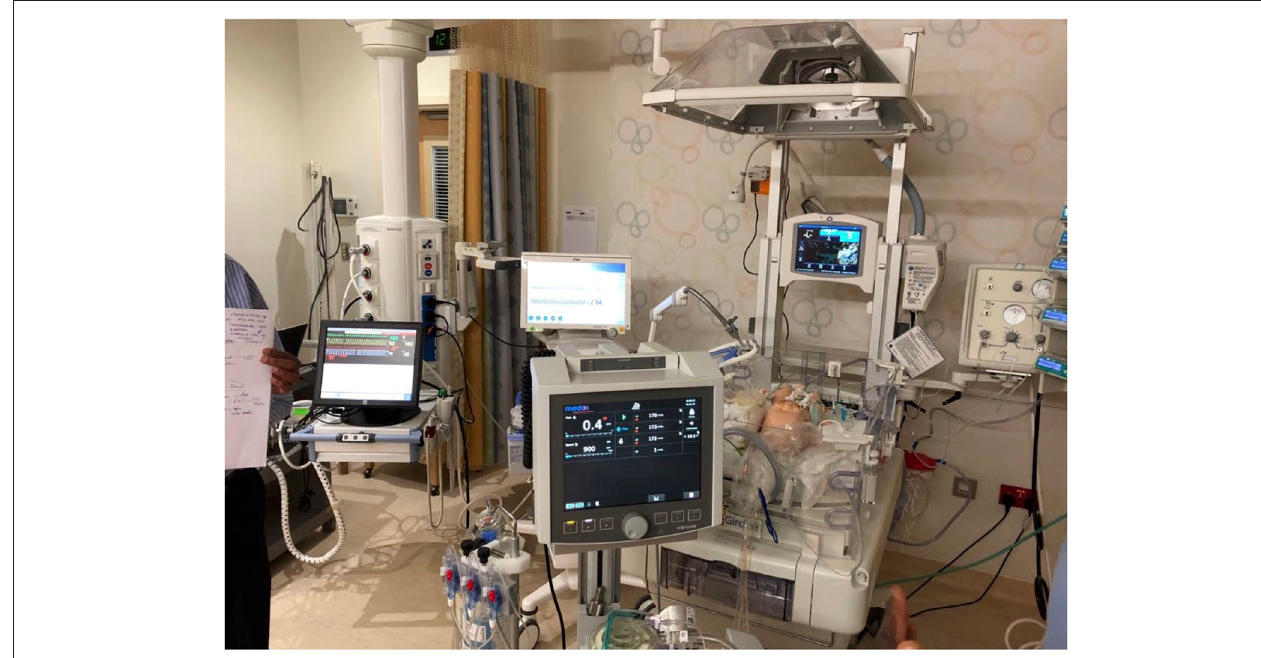
FIGURE 3 | Wet lab training/simulation.